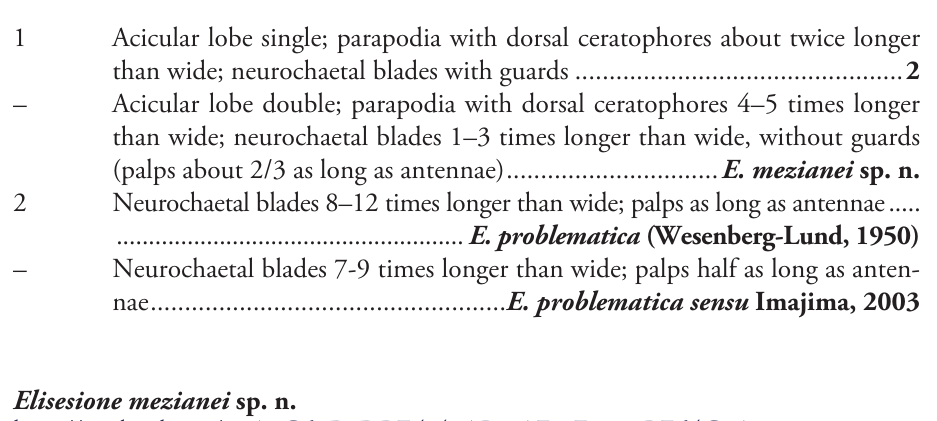
Figs 1, 2 Type material. Holotype (MNHN 1777), Musorstom Expedition 7, Wallis & Fu- tuna Islands, Sta. 536 (12°30.8'S, 176°41'W), Waren Dredge, Waterwitch Bank, 128 km NW off Wallis Island, 27–37 m, coralline rocks, crinoids, crabs, 16 May 1992, B. Richer,